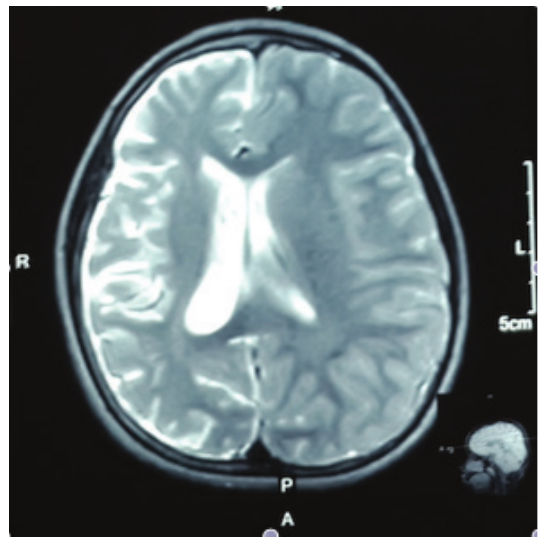
Figure 1: MRI brain showing dilated lateral ventricles